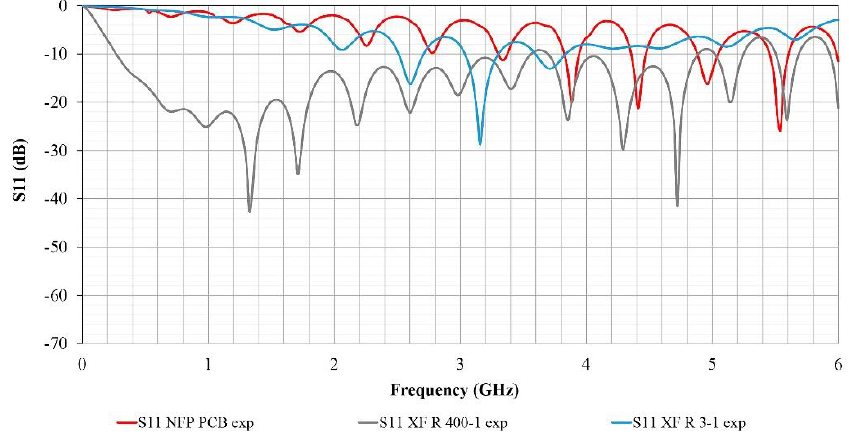
Figure 15. Comparison of the S 11 parameter measured with the NFP-PCB and the commercial probes.